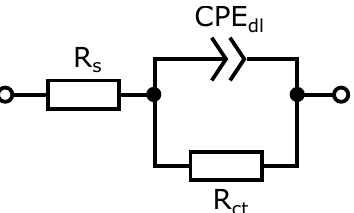
Figure 5. Electrical Equivalent Circuit used in experiment.